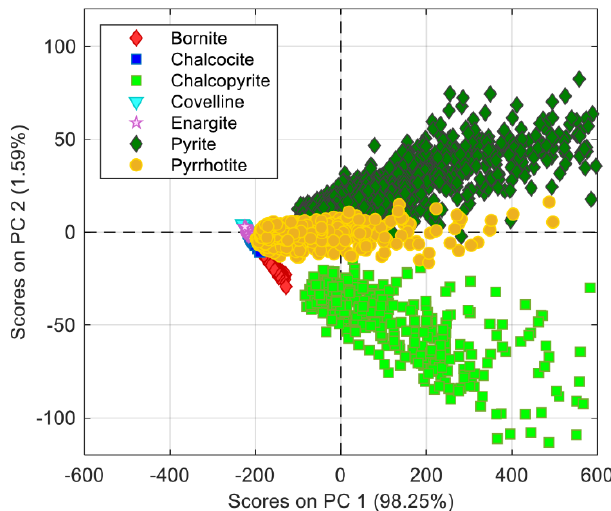
Figure 9. PC1–PC2 scores from PCA applied to experiments with mixtures of pure mineral species, taken from [23].